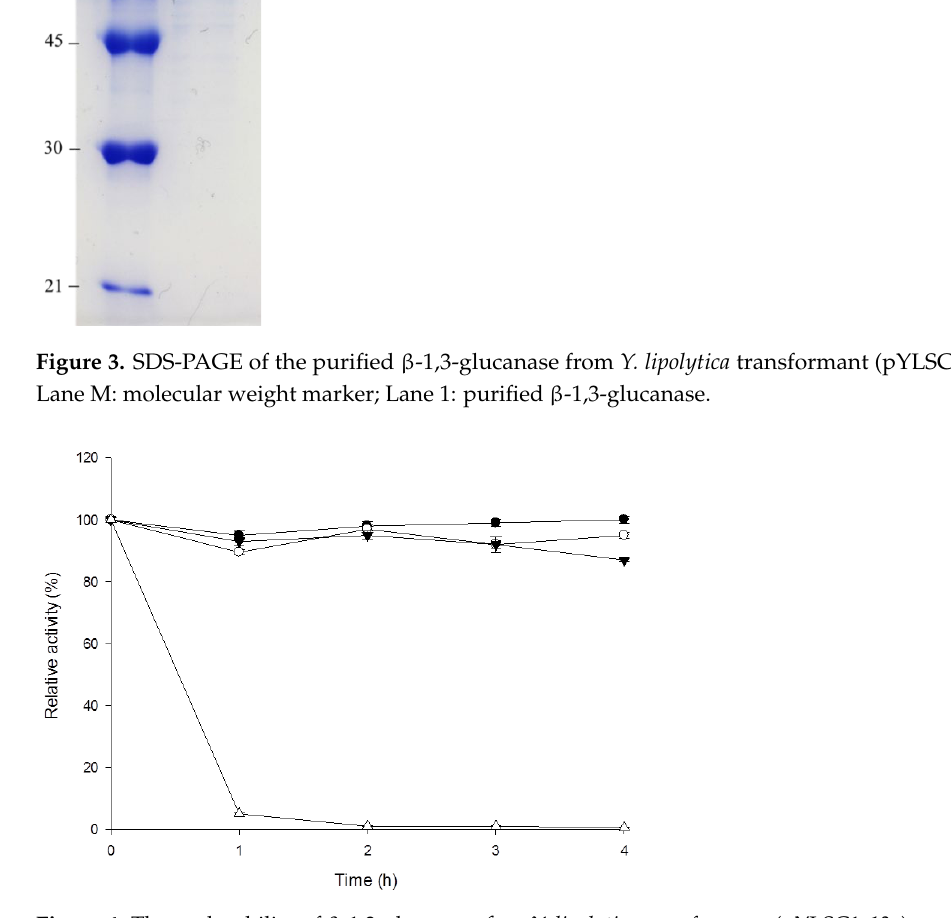
Figure 4. Therm al stability of β -1,3-glucanase from Y. lipolytica transformant (pYLSC1- 13g ). - ● - ： 40 °C; - ○ - ： 50 °C; - ▼ - ： 60 ℃ ; - △ - ： 70 °C .